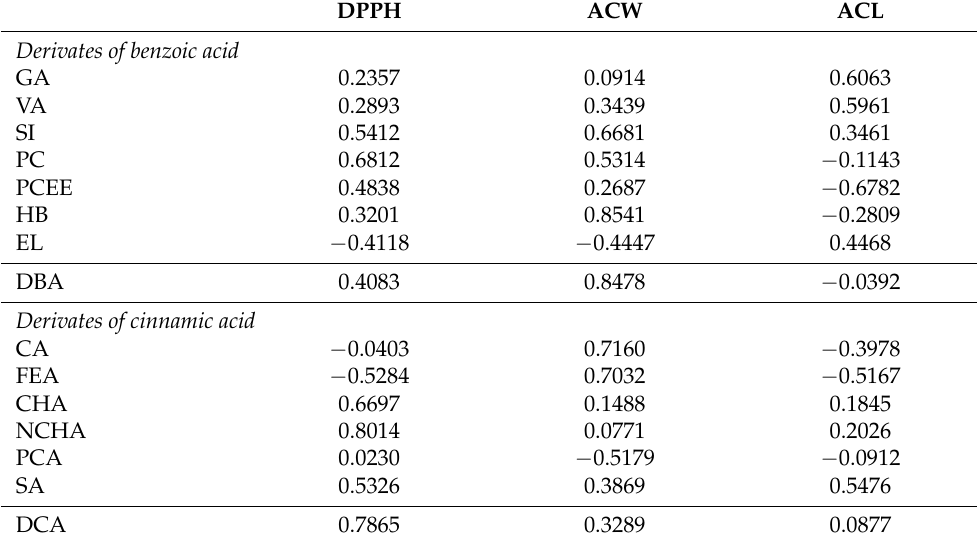
Table 12. Correlation coefficients (R) between different methods for AOA detection (DPPH, ACW and ACL) and individual phenolic acids (GA, VA, SI, PC, PCEE, HB, EL, CA, FEA, CHA, NCHA, PCA and SA), as well as total content of derivatives of benzoic acid (DBA) and total content of derivatives of cinnamic acid (DCA) in the samples of the selected Sorbus cultivars. DPPH ACW ACL Derivates of benzoic acid GA 0.2357 0.0914